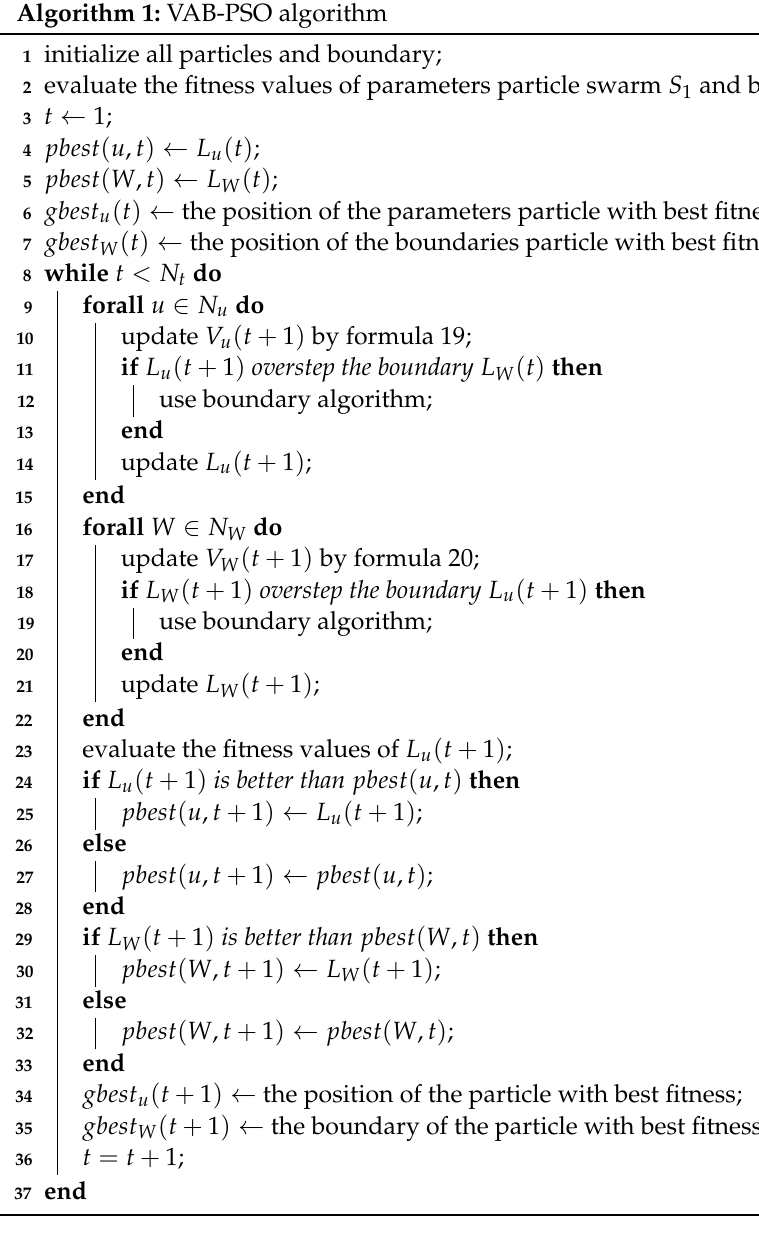
Algorithm 1: VAB-PSO